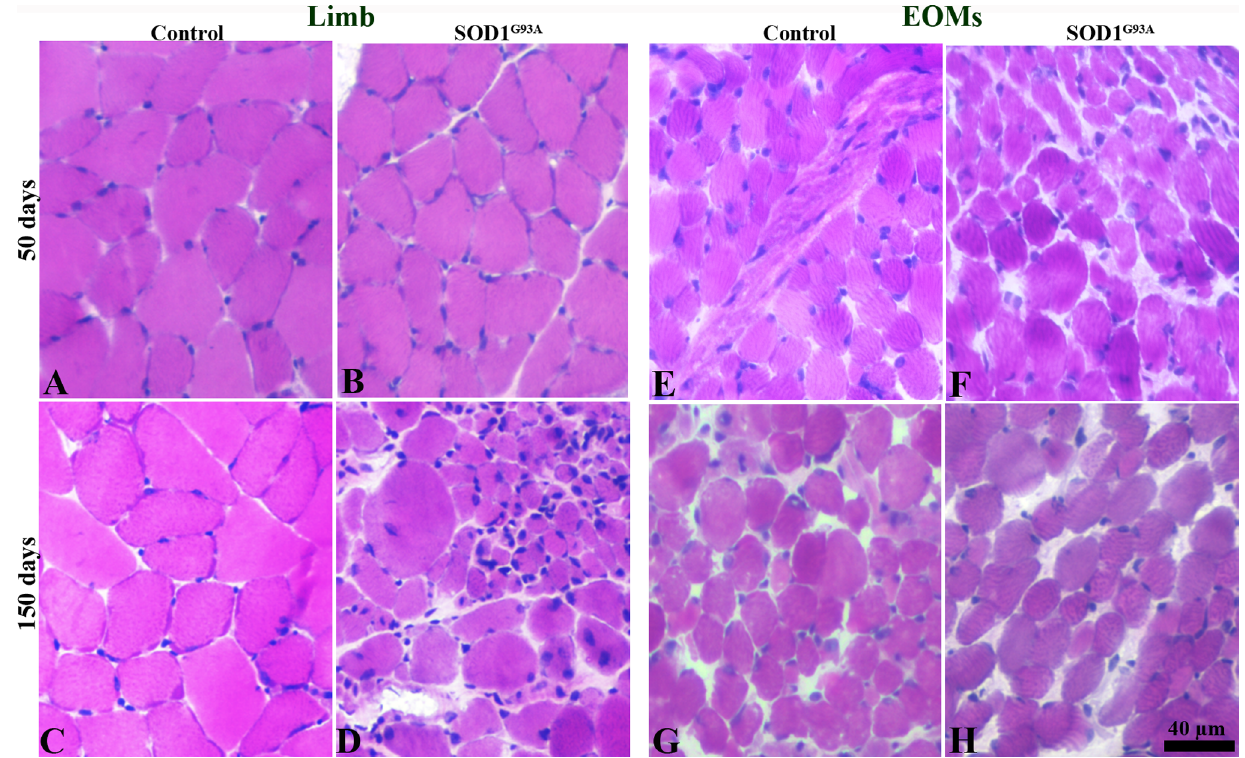
Figure 1. H&E staining of limb muscles (A–D) and EOMs (E–H) from control and SOD1 G93A mice at 50 days and 150 days. Normal morphological features of muscle fibres in limb muscles (B) and EOMs (F) at 50 days and in EOMs (H) at 150 days. In limb muscles of terminal stage